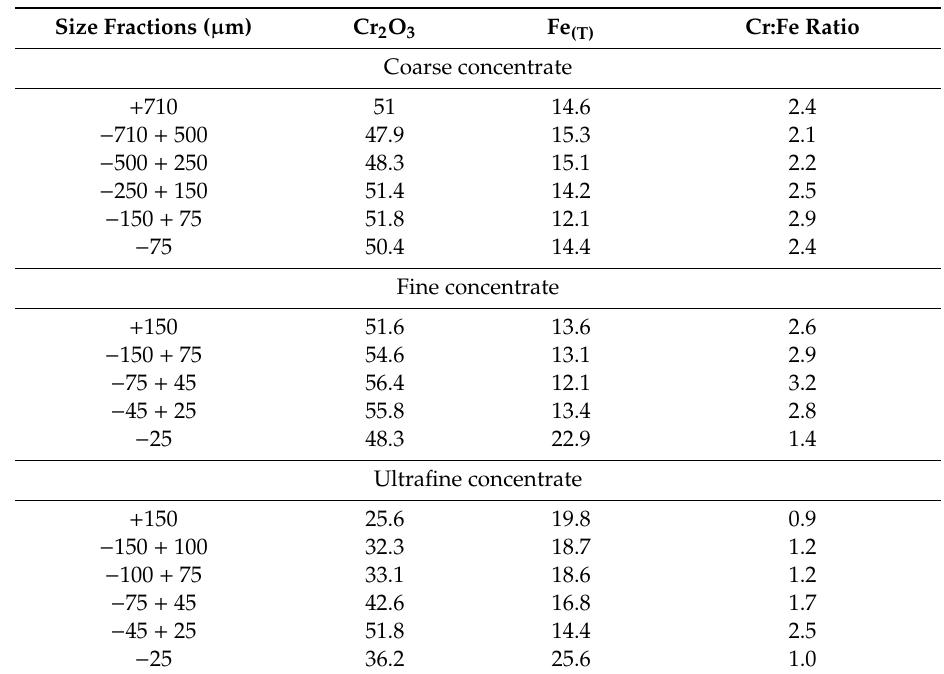
Table 3. Size by size elemental assay of the